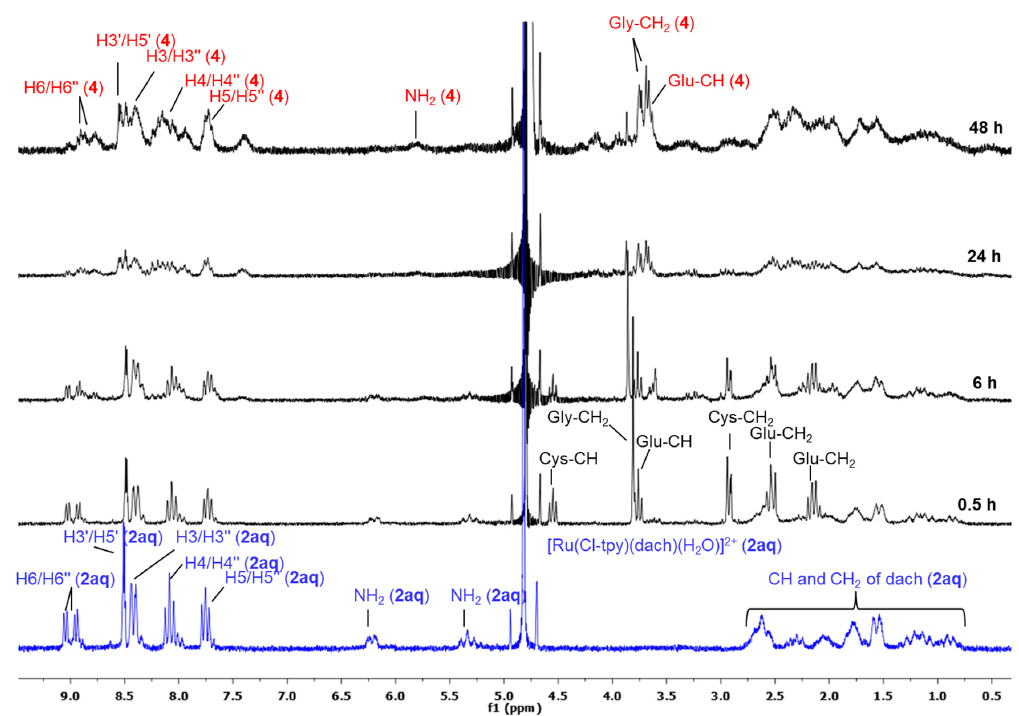
Figure 3. 1 H NMR spectrum of [Ru(Cl-tpy)(dach)(Cl] + ( Ru-2 , 10 mM) 10 min after dissolution in D 2 O and at various time intervals after addition of GSH.